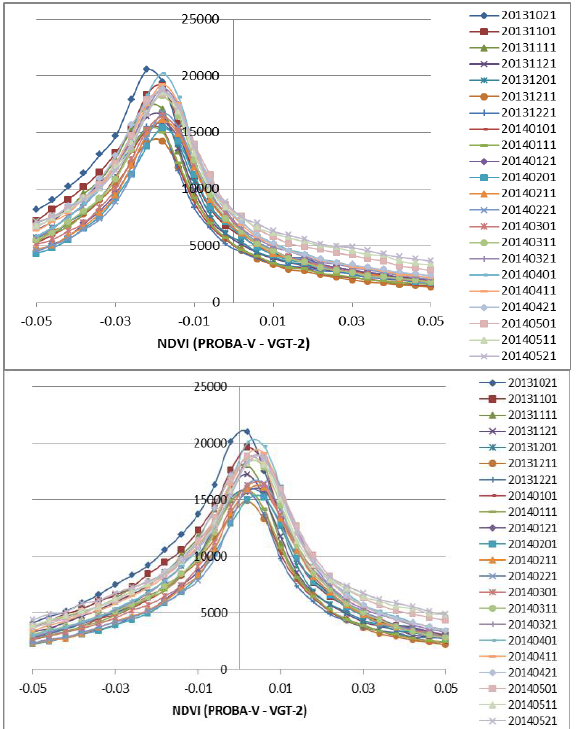
Figure 5. Histogram of the difference between the original (top), Set1 (middle) and Set2 (bottom) PROBA-V NDVI and VGT2 NDVI. Different curves are different composites